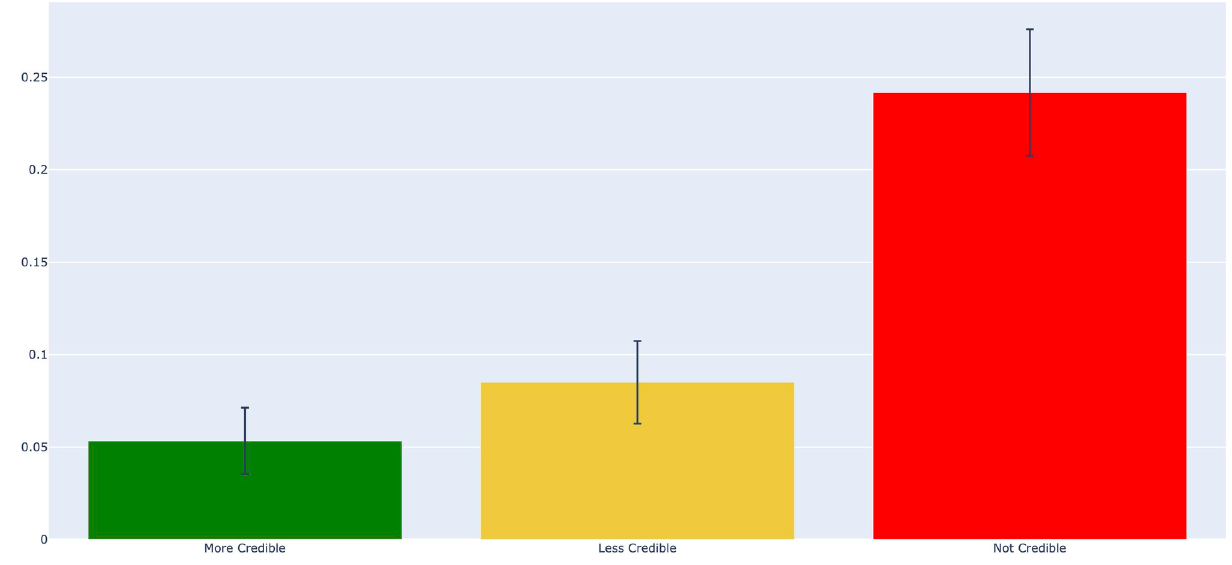
Fig 1. Proportions of misinformation for each credibility category. Error bars represent 95% confidence intervals.